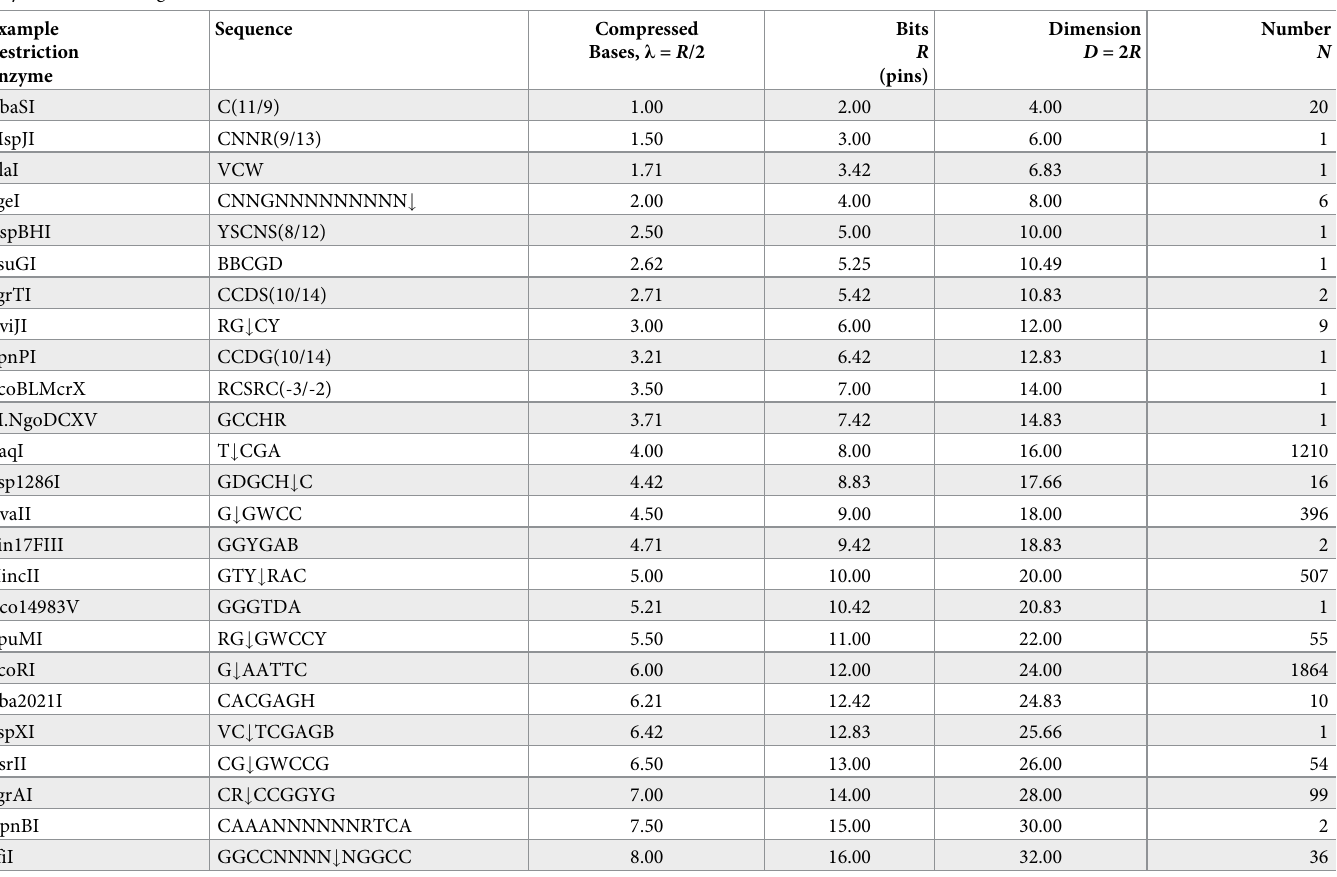
Table 1. Coding space dimensionality ( D ) and number ( N ) of restriction enzymes. The information content in bits, R , of the recognition sequence of 4297 restriction enzymes from REBASE (restriction enzyme database) http://rebase.neb.com or ftp://ftp.neb.com/pub/rebase/ version allenz.801 (Dec 27 2017) [40] was computed. A fully conserved base (A, C, G, T) contributes 2 − log 2 1 = 2 bits, two possibilities (R = G/A, Y = C/T, M = A/C, K = G/T, S = C/G, W = A/T) contributes 2 − log 2 2 = 1 bit, three possibilities (B = C/G/T, D = A/G/T, H = A/C/T, V = A/C/G) contributes 2 − log 2 3 � 0.42 bits and any allowed base (N) contributes 2 − log 2 4 = 0 bits [23, 41]. The sum of the information at each base, R , was used to find the corresponding number of compressed bases ( λ = R /2) and then the coding dimension ( D = 2 R ), assuming that each enzyme has an efficiency of � r = ln 2 and ρ = 1 so that there is a unique dimension according to Eq (21). The most commercially available enzymes and their reported recog- nition sequences are given as examples. When the DNA backbone cleavage site is known it is indicated by an arrow ( # ). The distance to cleavage sites outside the given sequence is shown in parenthesis for the corresponding and complementary strands. Star activity (variation within the canonical site) and flanking sequence effects are found for many restriction enzymes [42]. However, the patterns in the database are reported as consensus sequences that may distort the information content [43], and so may affect the results given